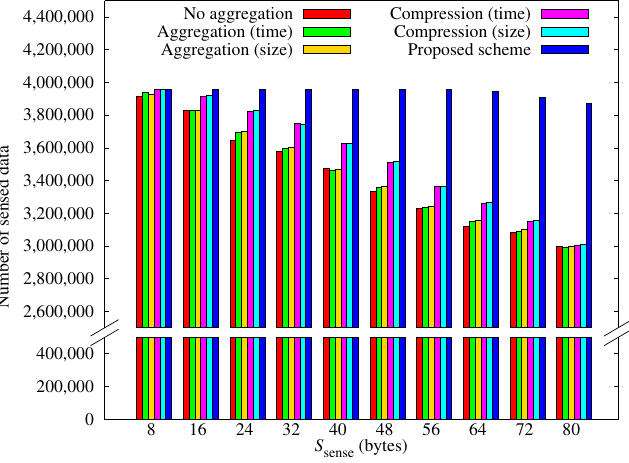
Figure 7. Comparison of the total amount of sensed